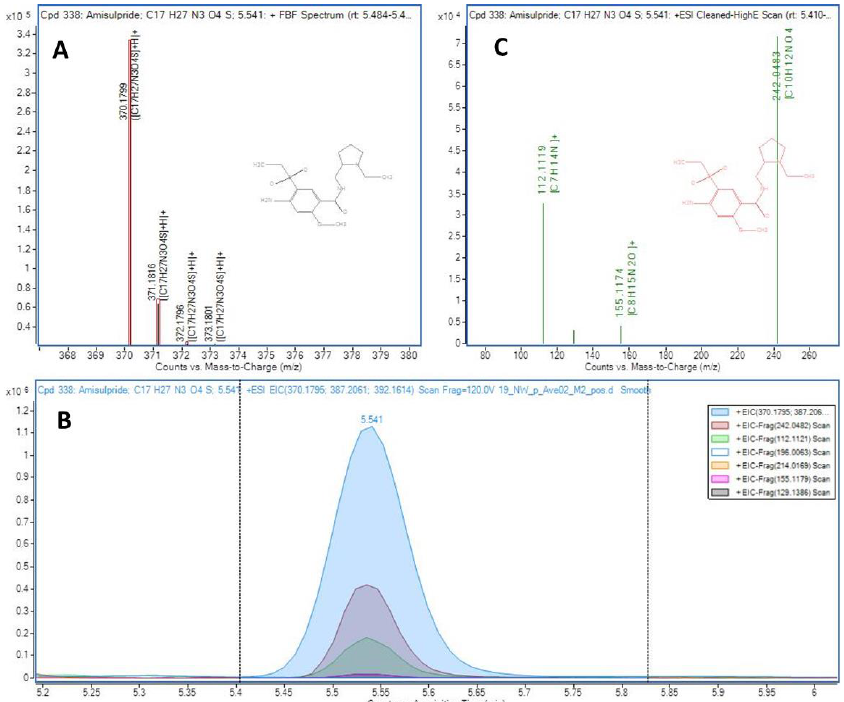
Figure 2. Identification of amisulpride in sample A2. ( A ) Match for the [M+H] + isotopic distribution (theoretical values as red boxes), ( B ) Extracted ion chromatograms for the co-eluting fragment ions in the high energy channel (20 V) and ( C ) Composite MS/MS spectrum generated by the software with the fragment ions matching the library information.